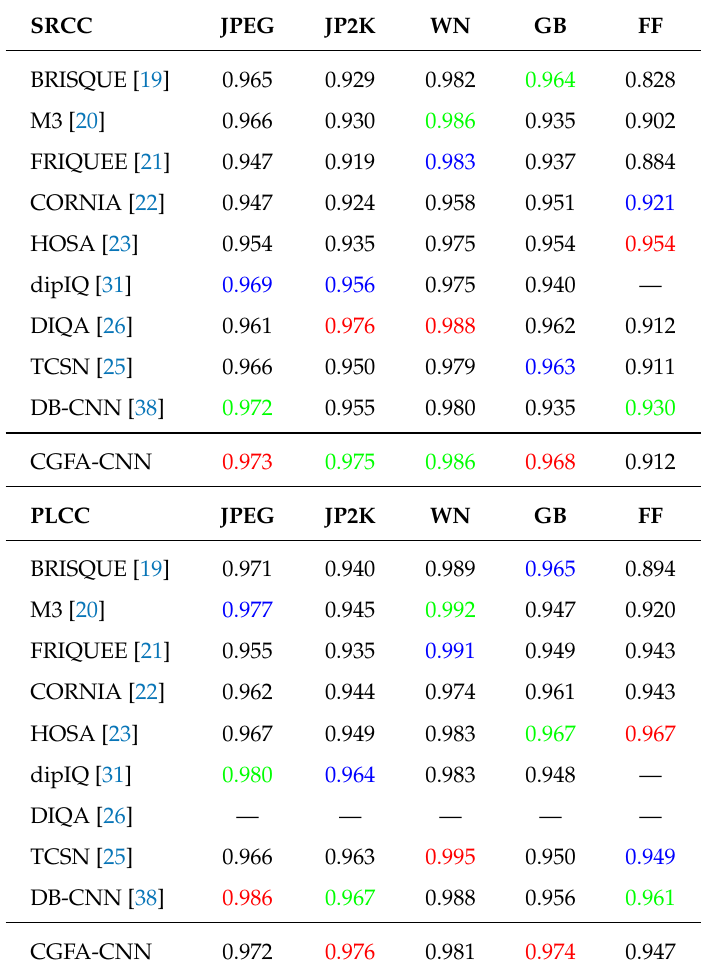
Table 3. Average SRCC and PLCC results of individual distortion types across ten sessions on LIVE database. The top three SRCC and PLCC results are highlighted in red, green, and blue,